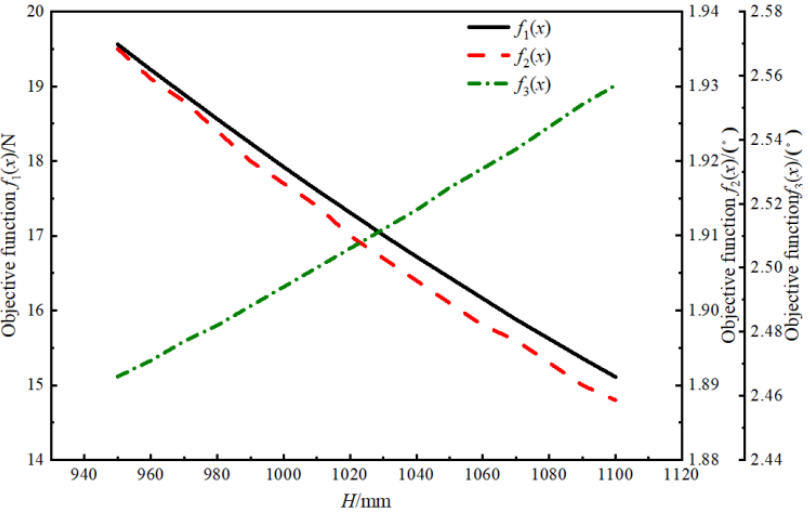
Figure 10. Variation curve of the objective function with the initial height H between the mobile and fixed platform.